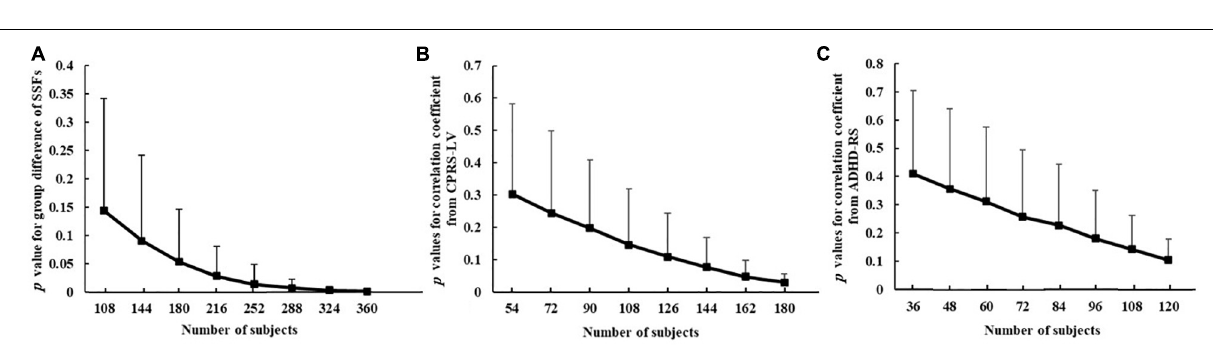
FIGURE 4 | Relationships between the expression of ADHD-related pattern and inattentive scores measured by CPRS-LV (A) and ADHD-RS (B) (ADHD, attention deficit hyperactivity disorder; CPRS-LV, Conners’ Parent Rating Scale long version; ADHD-RS, DuPaul ADHD Rating Scale IV).